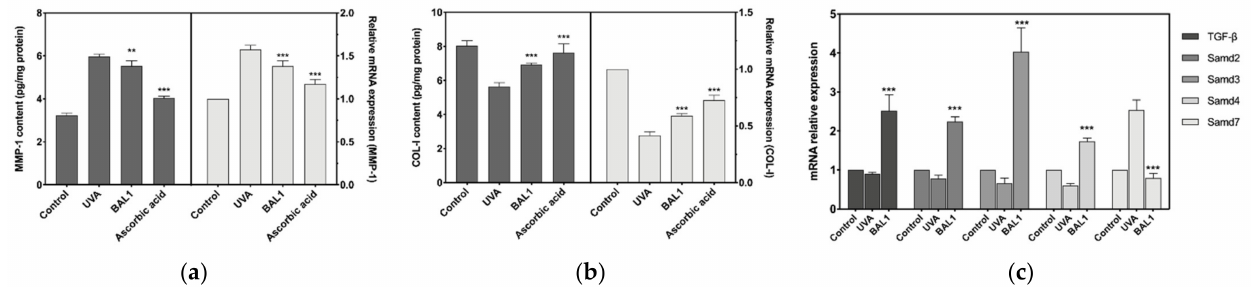
Figure 6. Effects of BAL1 on the breakdown and transcription of type I collagen. ( a ) The protein content of MMP1 and its transcription level. ( b ) The protein content of COL-I and its transcription level. ( c ) The protein content and transcription level of TGF- β and its mediating protein Smads. Difference analysis between sample group and UVA model group: **: p < 0.01, ***: p <